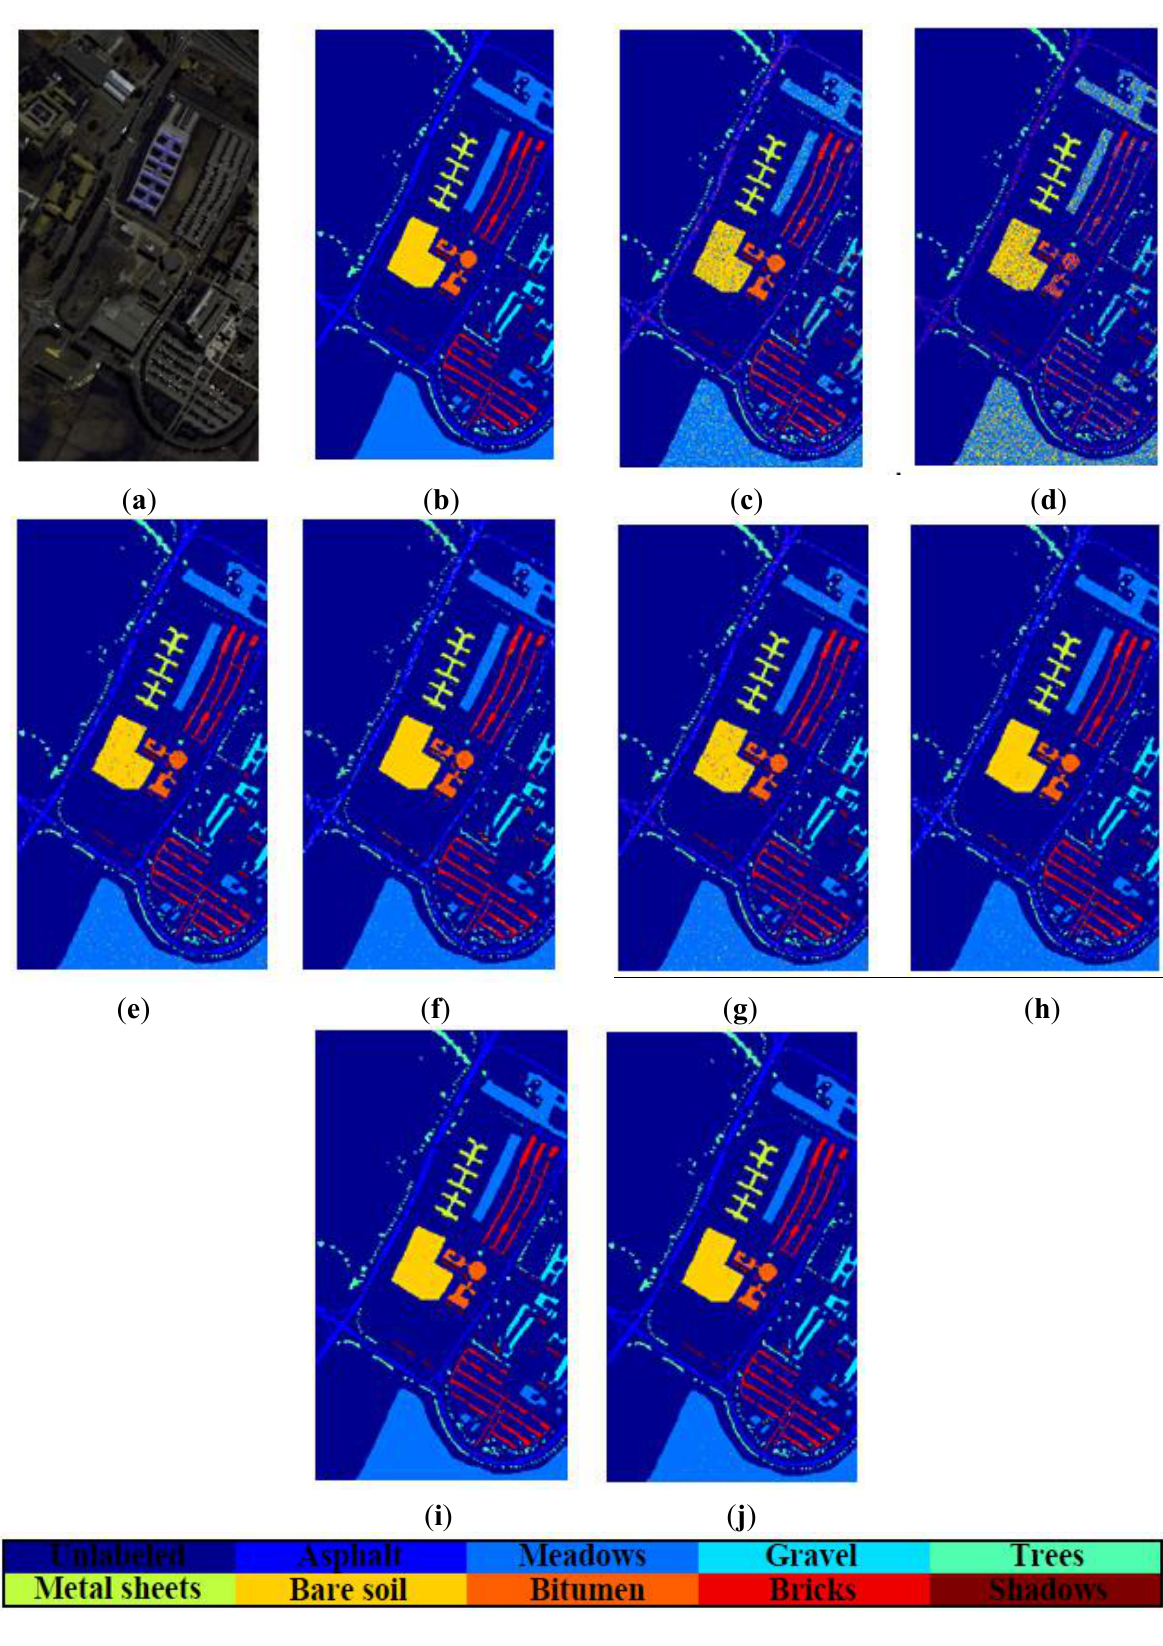
Figure 8. Thematic maps for the University of Pavia dataset with 60 training samples per class; ( a ) Pseudo-color Image; ( b ) Ground truth Map; ( c ) NRS; ( d ) SRC; ( e ) NRS + Gabor; ( f ) NRS + LBP; ( g ) SRC + Gabor; ( h ) SRC + LBP; ( i ) RF-NRS; ( j )